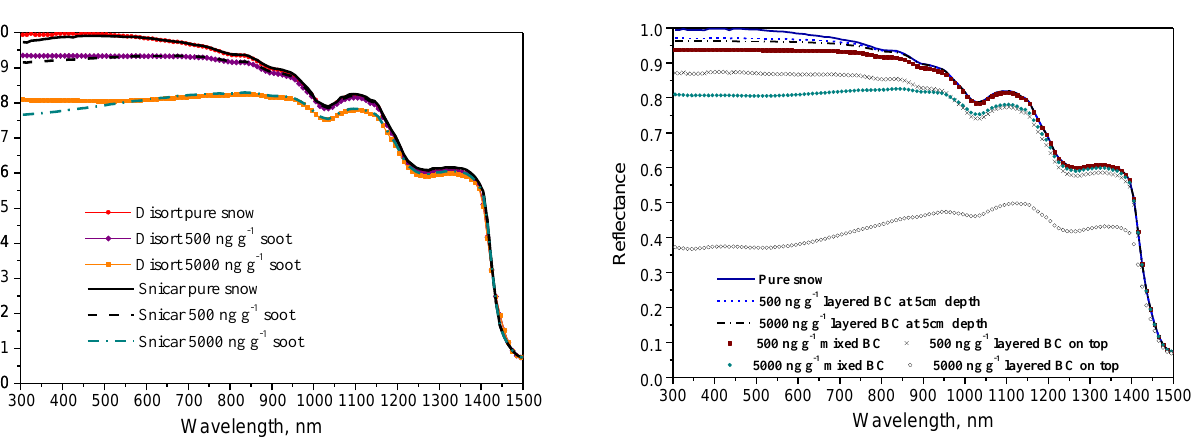
Fig. 9. Comparison of SNICAR-Online and DISORT calculated reflectances for pure snow and two contaminated snowpacks by wet deposition of BC.